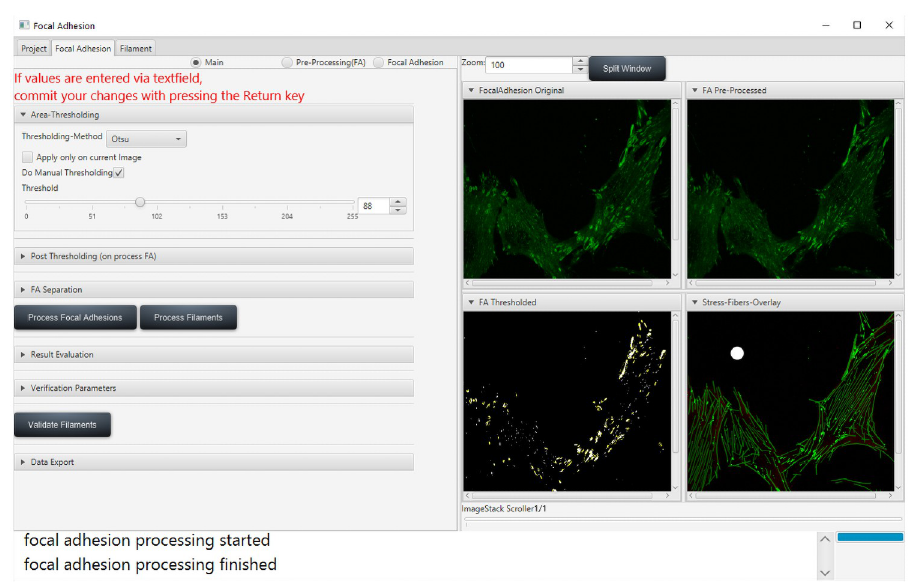
Fig 3. Main window of the FAFCK software. Main window of the GUI consisting of several sub-menus at the left to set threshold, FA size restrictions, validation preferences as well as routine for evaluation against external binary masks and data output options. On the right, processing output is shown and can be customized by the user or detached from the main GUI for a larger